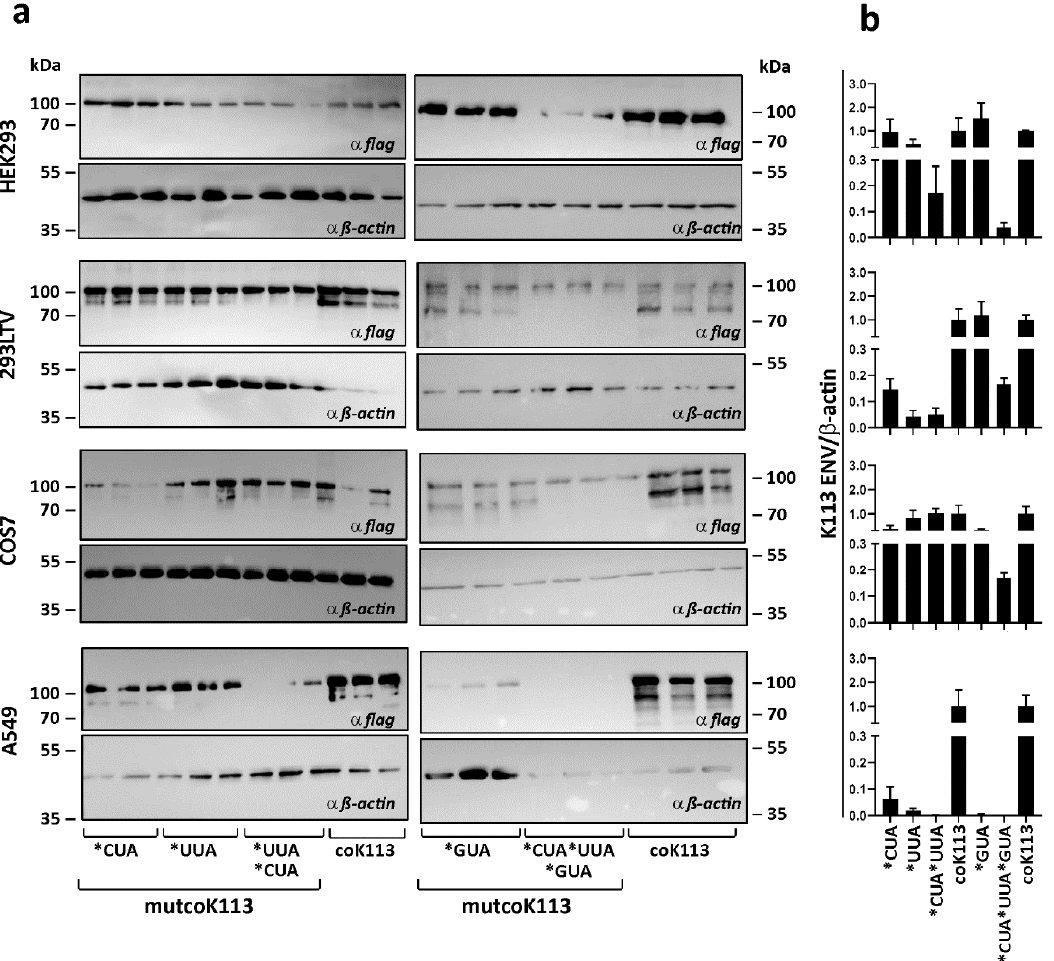
Figure 6. Expression of coK113 ENV mutants in mammalian cells. ( a ) Three human cell lines (HEK293, 293LTV, and A549) and monkey COS7 cells were transfected with expression vectors containing codon-optimized (coK113) or rare codon mutants of this sequence (mutcoK113). After 24 h the cells were harvested. Total amount of 20 µg protein from three independent experiments was analyzed by Western blotting. For detection of ENV, staining against their C-terminal FLAG tag was performed. As reference the expression of β -actin was observed. ( b ) Densitometric analysis of normalized expression level is shown. The expression of ENV precursors was measured and normalized to expression of β -actin by densitometric analysis using ImageJ software. The complete codon-optimized ENV was set as 1. Mean and standard errors were calculated and visualized by GraphPad Prism5.